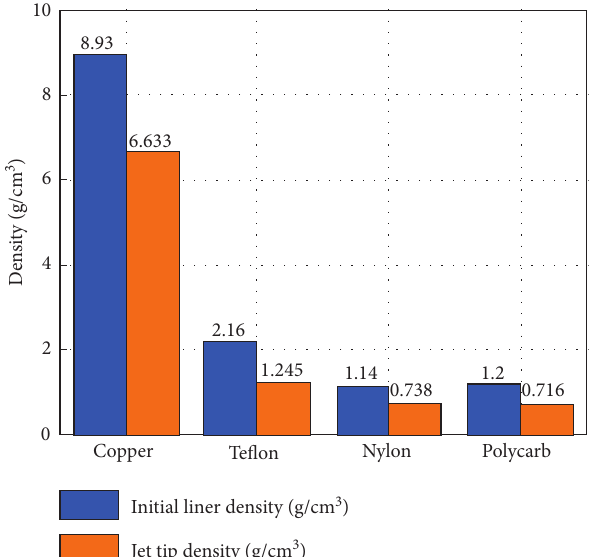
Figure 7: Jet density comparison before and after micro-jet for- mation at the distance of 2.5CD.